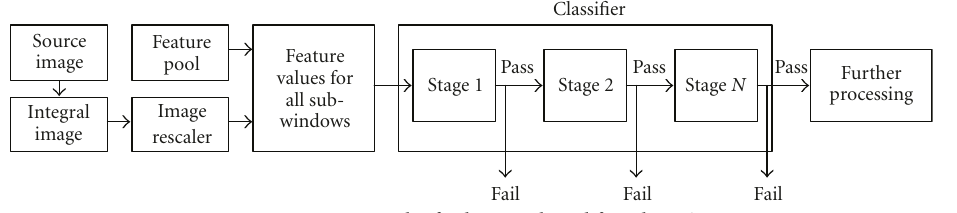
Figure 1: Framework of AdaBoost-based face